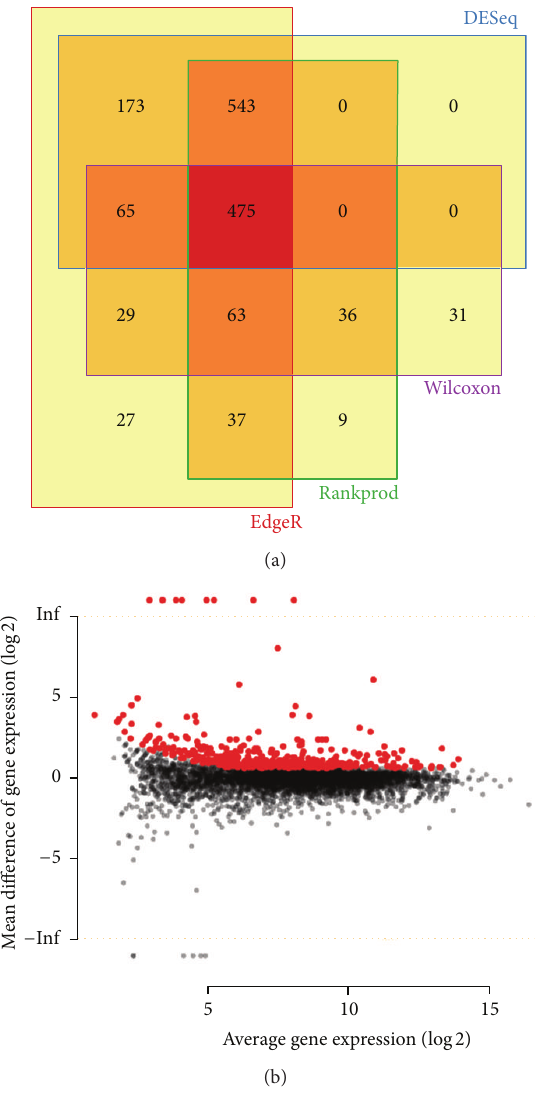
Figure 3: Differentially expressed genes (DEGs) identified by dif- ferent statistical methods (a) and global review of differentially expressed genes in powdery mildew resistant (red dot) and suscep- tible (black dot) genotypes in Lagerstroemia indica species (b).